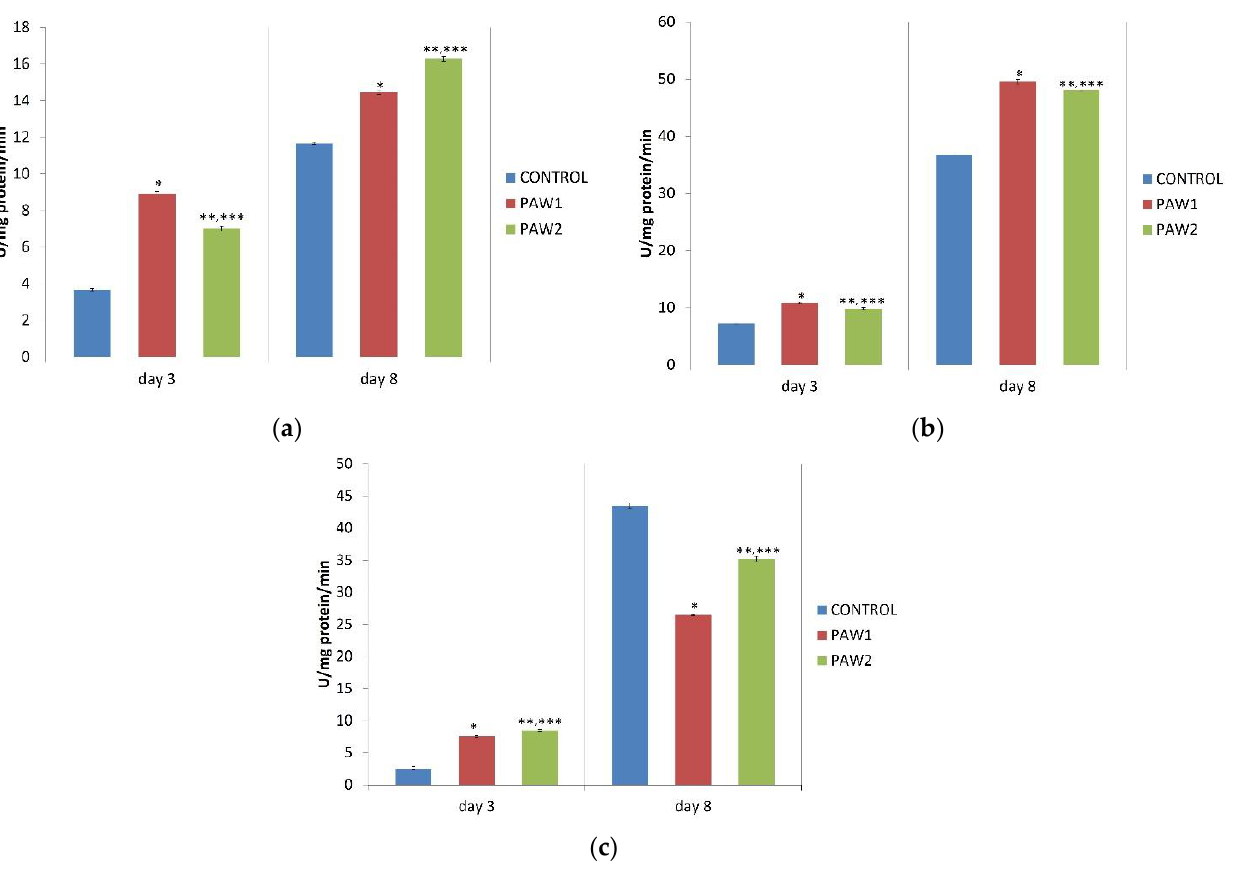
Figure 7. Antioxidant activity of the free ( a ) and bound ( b ) phenolic fractions isolated from Triticum aestivum L. cv. Glosa sprouts (days 1, 2, and 3) and shoots (day 8); * significant difference ( p < 0.05) between control and PAW1; ** significant difference ( p < 0.05) between control and PAW2; *** significant difference ( p < 0.05) between PAW1 and PAW2. Each point represents the mean ± SD of three determinations.